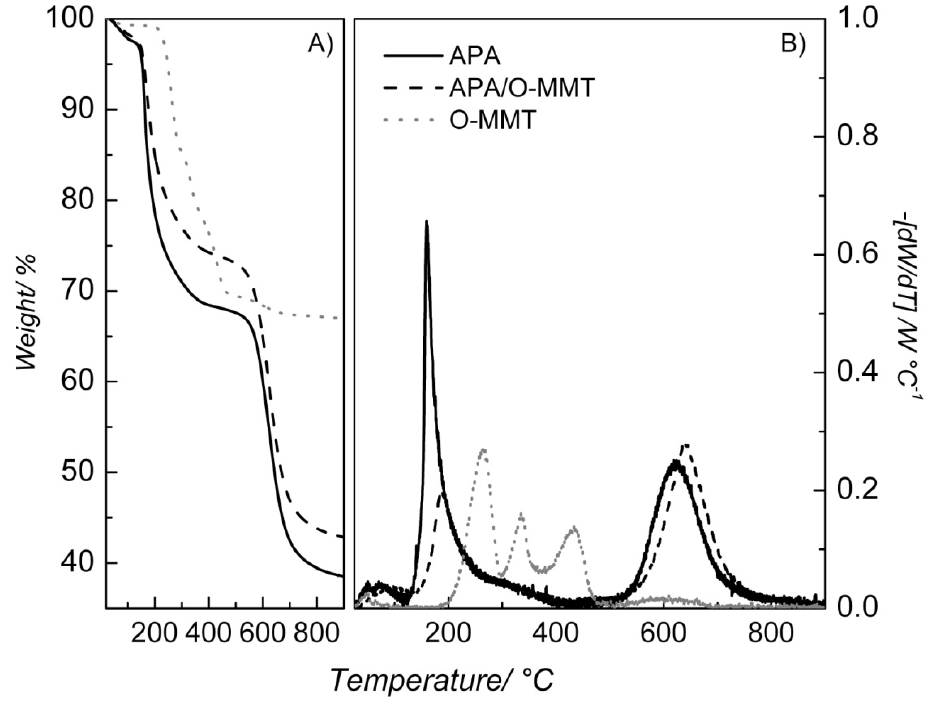
2 Figure 5. Thermal gravimetric analysis (TGA) ( A ) and DTGA ( B ) curves for the materials employed in this work. The identity of the samples is indicated in the figures.